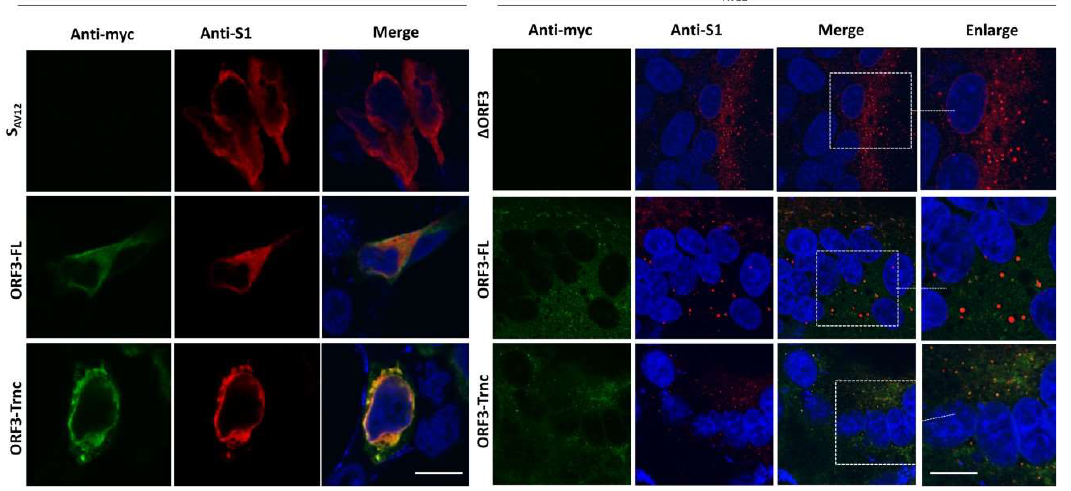
Figure 6. Co-localization of the ORF3 and S proteins in transfected and infected cells. HEK293T cells were co-transfected with pCAGGS_ORF3s-myc (ORF3-FL or-Trnc) and pCAGGS_S AV12 ( left panel ) or infected by the PEDV AV12 _ORF3s-myc (ORF3-FL or-Trnc) ( right panel ). The PEDV AV12 _∆ORF3 was used as a control. Cells were stained with rabbit anti-myc and mouse anti-S1 antibodies followed by incubation with goat anti-rabbit IgG Alexa flour 488 and-mouse IgG Alexa flour 647 antibodies. Nuclei were stained with Prolong Gold Antifade Mountant with DAPI. Co-localization of PEDV ORF3s with S proteins was analyzed by confocal microscopy. Scale bars are 10 µm.